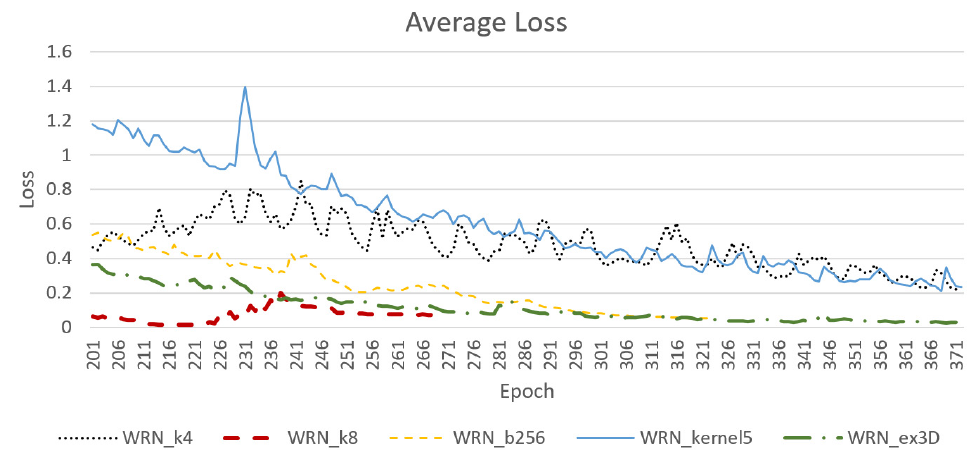
Figure 11. Terminal convergence results of average loss under the condition where the samples were randomly distributed between training and testing sets at a 7:3 ratio (epochs 201–369).